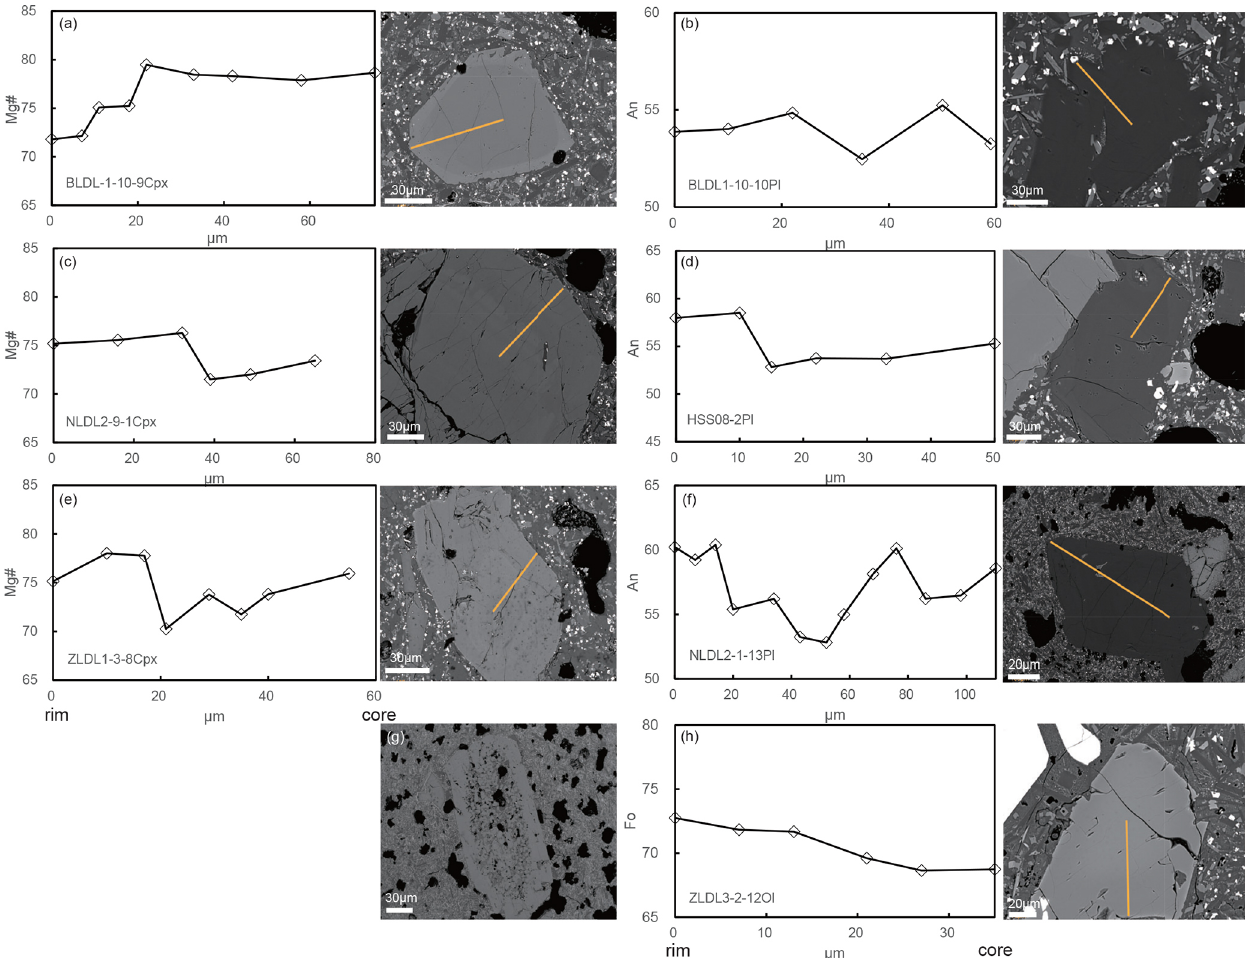
Figure 5. Rim-to-core compositional profiles of representative olivine, clinopyroxene and plagioclase crystals from the WVF. Yellow lines in BSE images mark measured line profiles. (a) A representative normal-zoning trend of clinopyroxene from BLDL, with a high Mg# core surrounded by a narrow low-Mg#-overgrowth rim. (b) Normally zoned An mole percent profiles of plagioclase from BLDL. (c–d) Example of reverse-zoned clinopyroxene and plagioclase from NLDL and HSS, respectively, characterized by Mg-poor or An-poor cores surrounded by Mg-rich or An-rich rims. (e–f) Complexly zoned clinopyroxene and plagioclase, showing a normal composition core or Mg-rich cores with the mantle displaying variable reverse or normal zoning in ZLDL and NLDL, respectively. (g) Sieve-textured clinopyroxene from ZLDL. (h) Reverse-zoning olivine from ZLDL, with Mg# continuously rising from core to